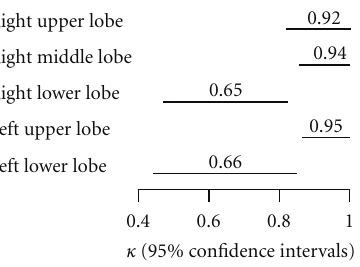
Figure 5: Cohen’s kappa values by lobe of lung, with lines display- ing bootstrap 95% confidence